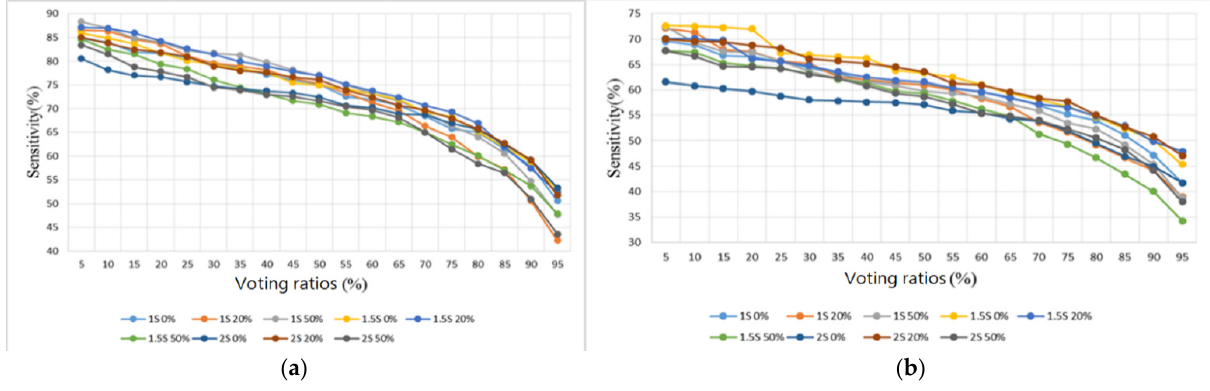
Figure 16. Heart sound classification results: Accuracy. ( a ) Testing samples. ( b ) Noisy samples.